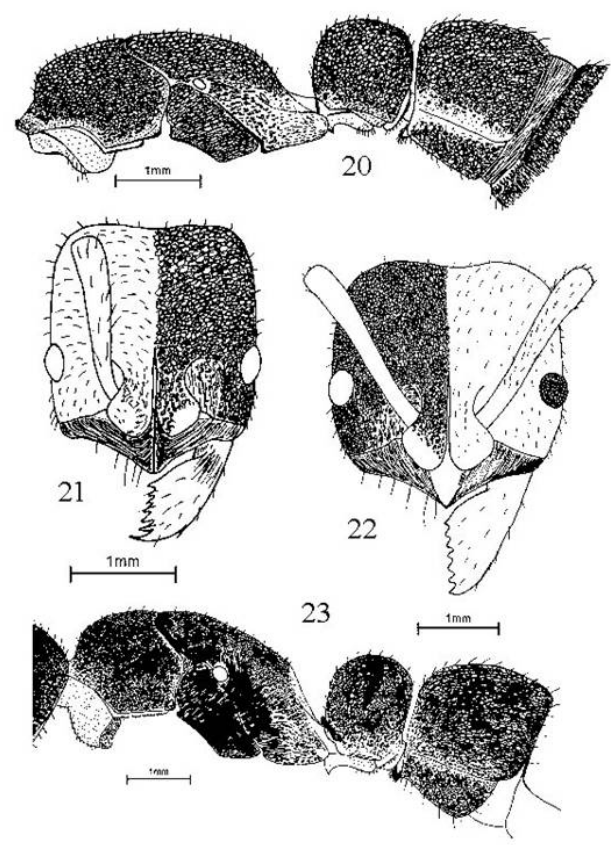
Fig 20 . The lateral view of the holotype worker of B. strigulosa (MCSN). Fig 21 . The head of the holotype worker of B. strigulosa (MCSN). Fig 22 . The head of the holotype worker of B. umgodikulula (MCZC). Fig 23 . Lateral view of the holotype worker of B. umgo- dikulula (MCZC).